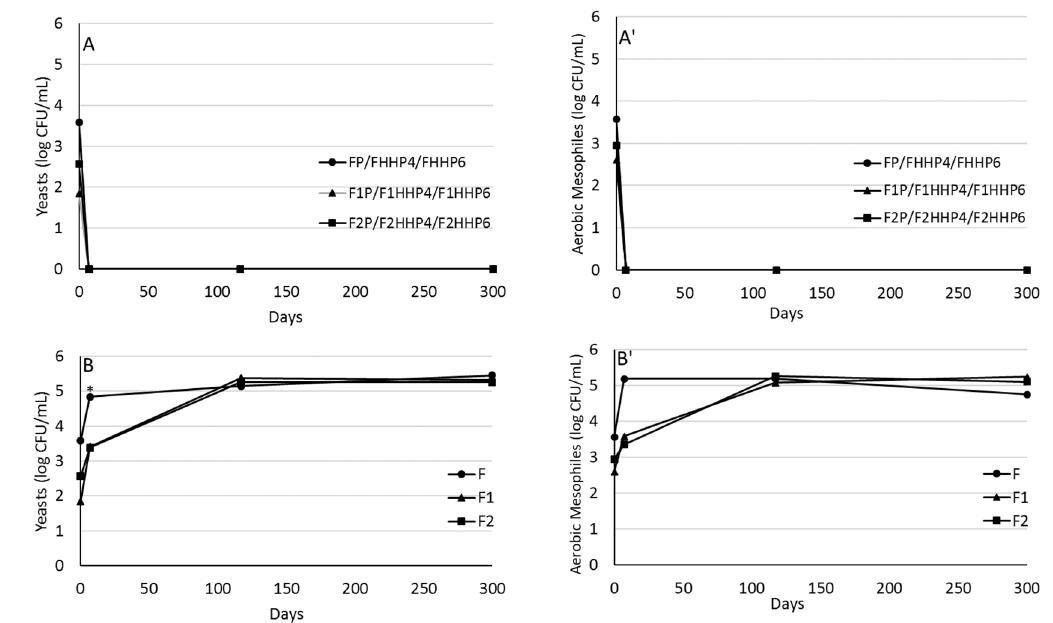
Figure 1. Evolution of yeasts counts and aerobic mesophilic microorganisms in pasteurized (FP, F1P, F2P), HHP 400 MPa 4 min (FHHP4, F1HHP4, F2HHP4) and HHP 400 Mpa 6 min (FHHP6, F1HHP, F2HHP6) treated table olives ( A , A’ ) and untreated table olives (control) ( B , B’ ). *: statistically significant differences (Tukey’s Test, p < 0.05) among conservation treatments at the same storage